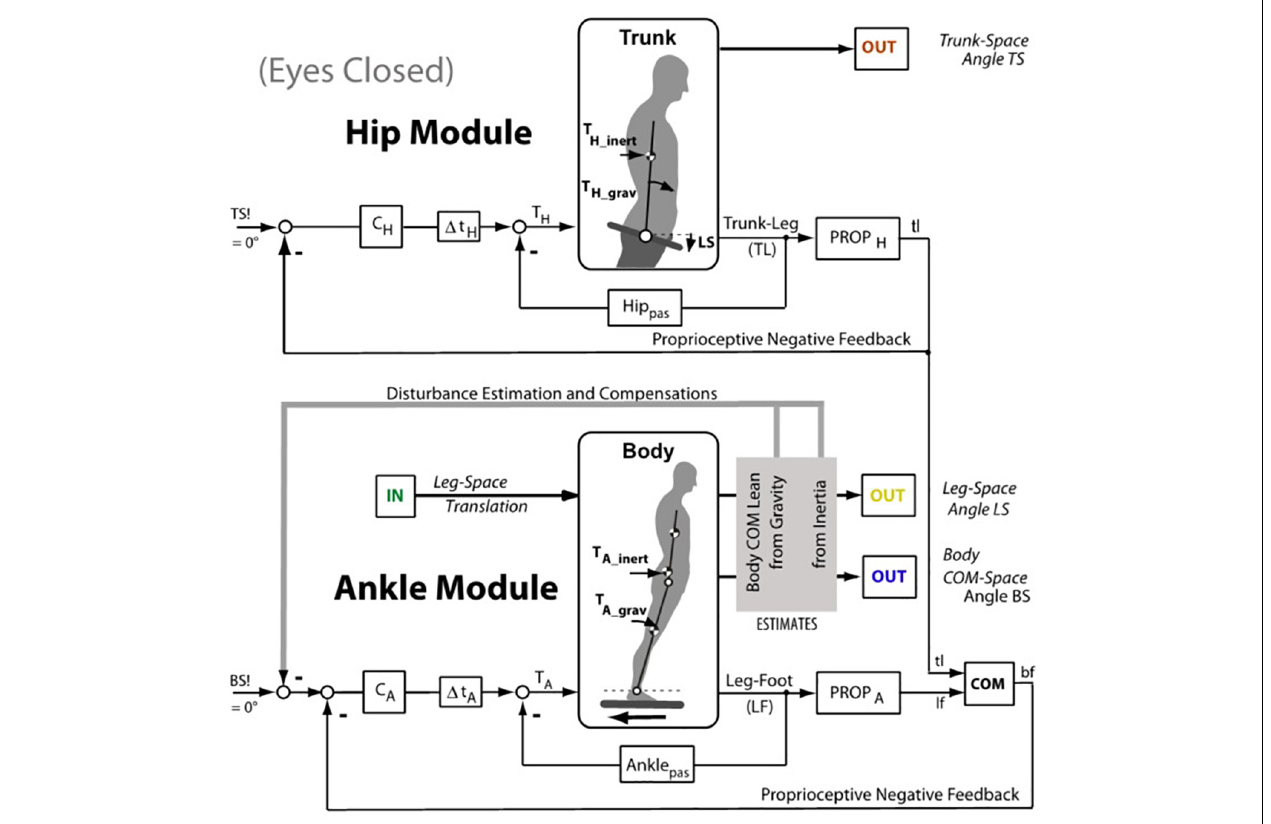
FIGURE 4 | Inverted pendulum model (simplified version of the model used by Hettich et al. (2014). The lower half (Ankle Module) shows the control of the body center of mass (COM) with negative feedback from proprioception and passive tissue (pas). The input is desired body COM orientation in space (BS!; 0 ◦ , upright). The controller C A (proportional-derivative) provides after the lumped time delay (cid:49) t the ankle torque T A that stabilizes at rest the upright body pose through the feedbacks from ankle proprioception (PROP A ) and passively from connective tissue (Ankle pas ). During support surface translations, deviations from the earth vertial body pose by the translation evoked inertial and gravitational ankle torque (T A − inert ; T A − grav ) are compensated for by a Disturbance Estimation and Compensation (DEC) mechanisms (gray box; details in Supplementary Appendix A ). The role of the upper body stabilization on the hip joints for whole body COM stabilization follows comparabale principles and is adding to the sway of the body COM. In the context of the present experiments, we considered two modeling scenarios, one where the gain of the hip module was so much enhanced that essentially a SIP sway in the ankle joints resulted, and the other where a DIP scenario with additional sway in the hip joints resulted. In the latter case, a damping of the body sway responses from support translation in the ankle joints resulted, adding to sway damping resulting from visual input (details in Supplementary Appendix B ). The figure emphasises that the balancing involves both, the ankle joint control and the hip joint